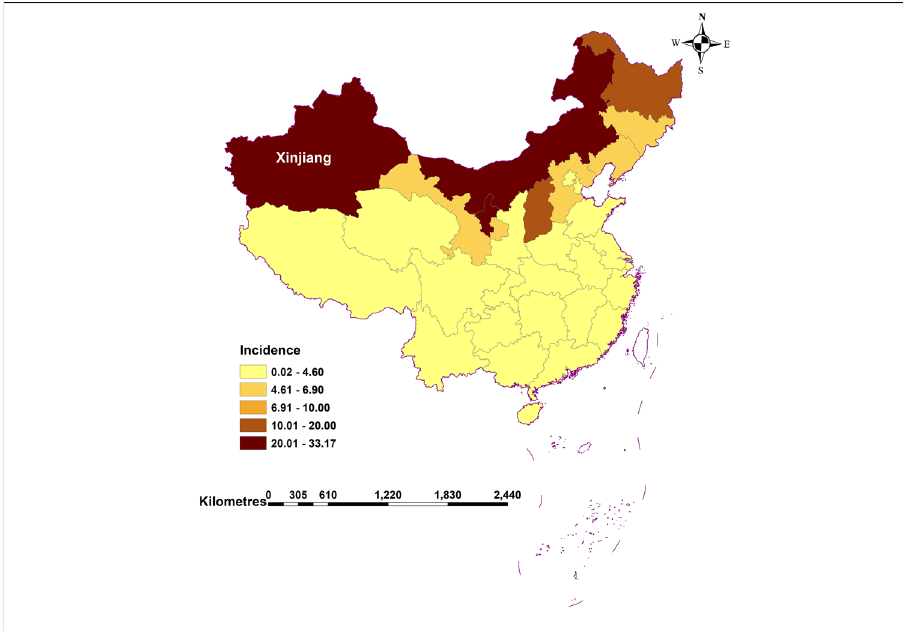
Figure 1. The average annual incidence (per 100,000 populations) of human brucellosis in China from 2014 to 2017. (This figure is plotted by ArcMap10.4.1).